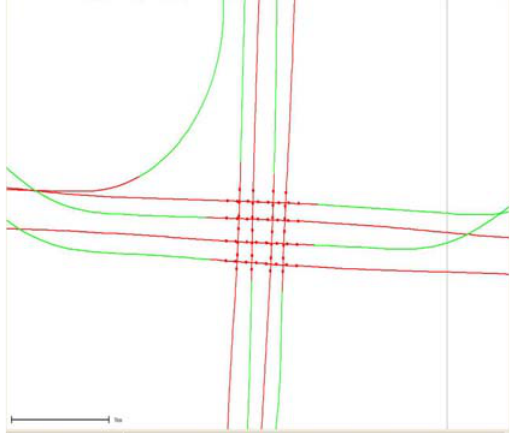
Figure 2: Flight